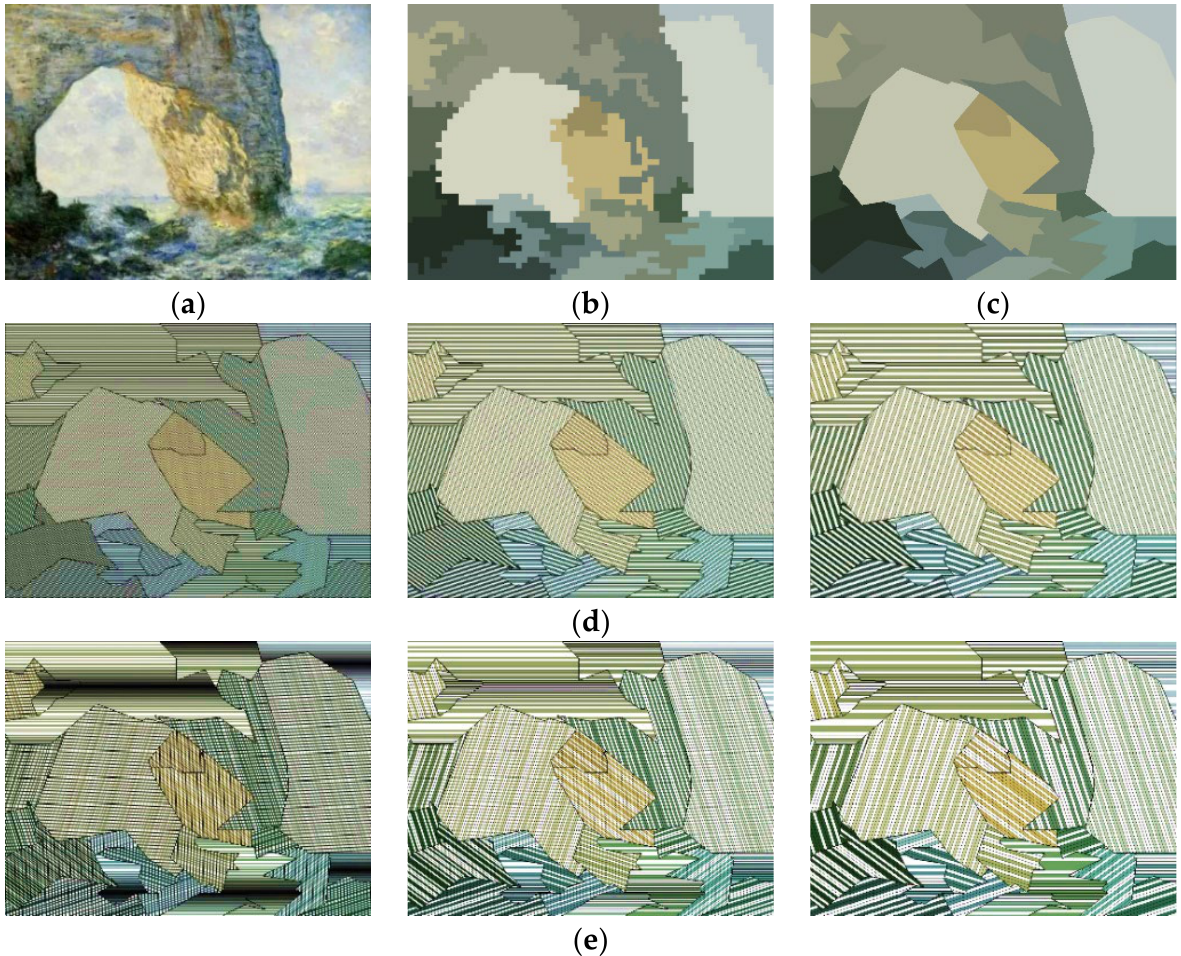
Figure 13. Experimental result 1. ( a ) An original image, “The Manneport, Rock Arch West of Etretat,” by Claude Monet, 1883. ( b ) The result of image segmentation of ( a ). ( c ) The result of polygon approximation of ( b ). ( d ) Three Futurism-like images created from ( a ) with the stripe widths of 3, 6, and 9 pixels, respectively. ( e ) Three stego-images created from ( a ) by embedding the message “One is never too old to learn.” with the secret key “Monet” and the stripe widths of 3, 6, and 9 pixels, respectively.